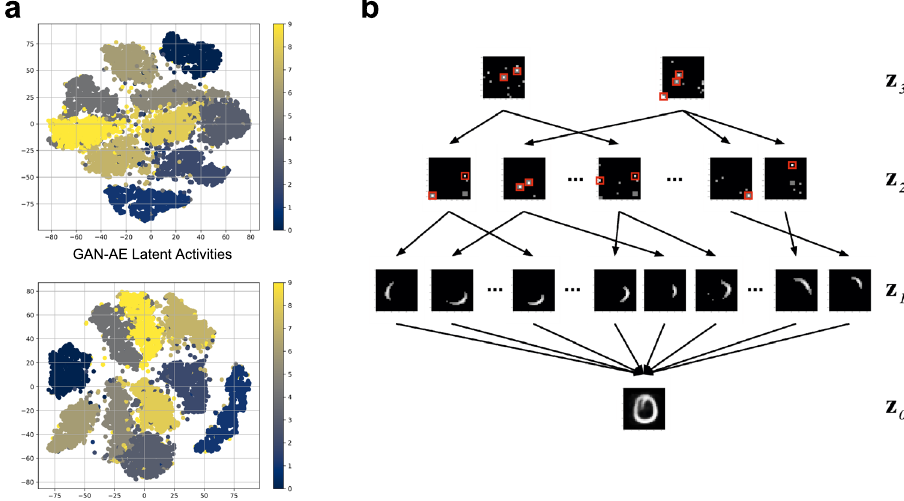
Fig. 6 Examination of model latent activities. a t-SNE plot of latent codes of the GAN-AE and GNCN-PDH on the MNIST database. b Illustration of an NGC network composing the digit zero that was randomly sampled from the MNIST database (all the feature maps shown in this image have been extracted from one of the GNCN-t2-L Σ models trained on MNIST). Note that layers 2 and 3 ( z 2 and z 3 ) control a hierarchical neuron selection pathway which leads to excitation (turning on) or suppression (turning off) of certain low-level neurons in layer 1 ( z 1 ) that contain visual features that are super- imposed to generate a fi nal output image. The image maps shown corresponding to z 2 and z 3 are visualized synaptic weight vectors that appear to serve as blueprints for choosing units (white indicates neurons to excite and black indicates neurons to suppress, after normalization was applied to the original maps and values lower than a threshold of 0.5 were set to black). Red squares have been added to indicate the neurons with some of the highest activity values that select the most important visual features that will be used to compose a fi nal output predicted image.